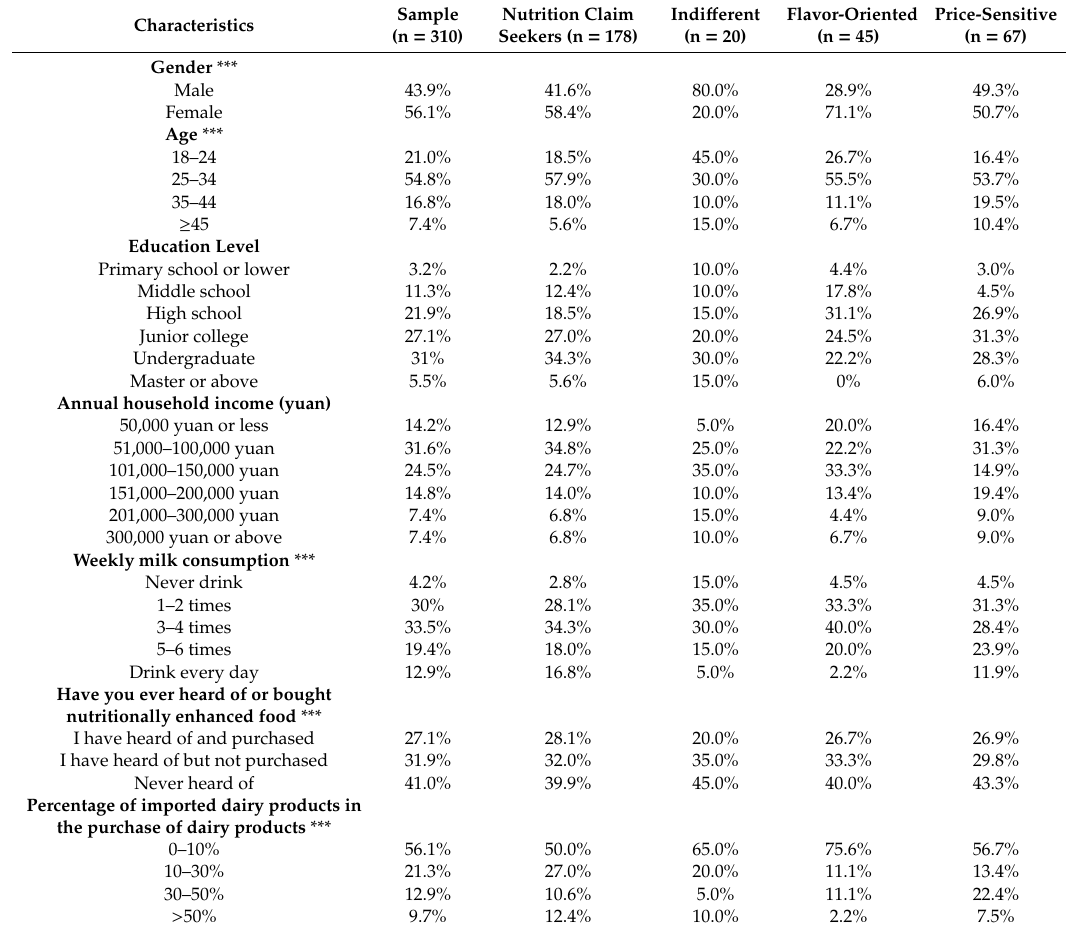
Table 2. Demographic characteristics and consumption